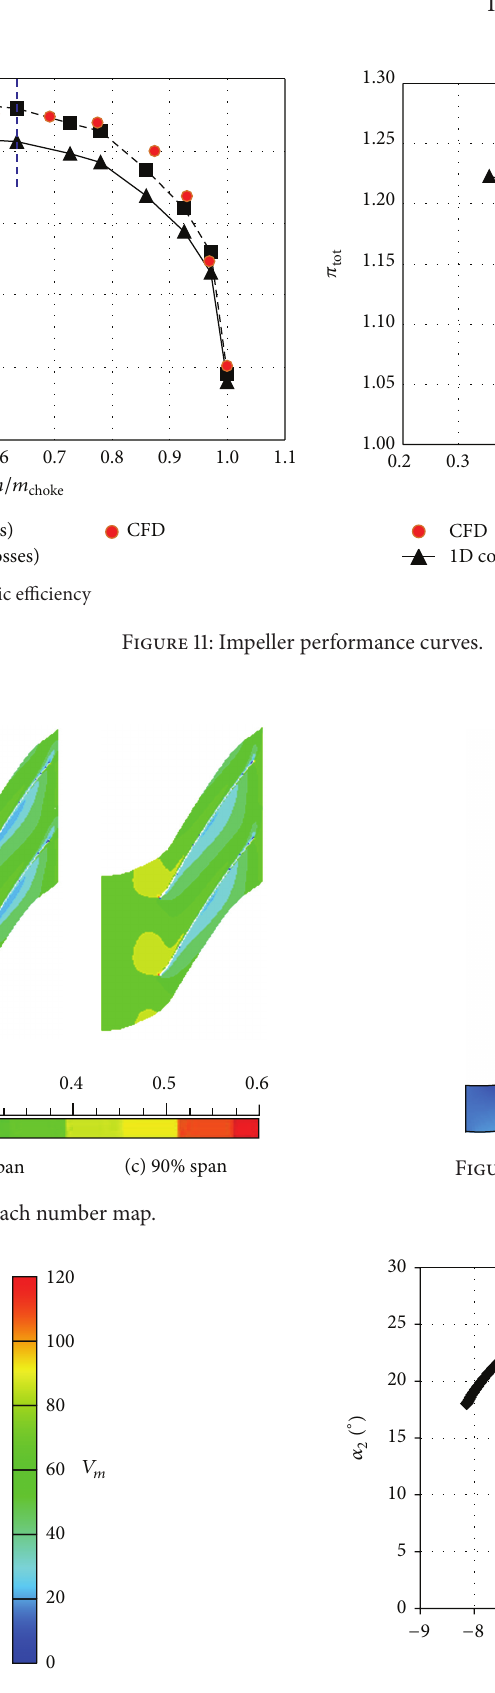
Figure 15: Absolute flow angle distribution at impeller